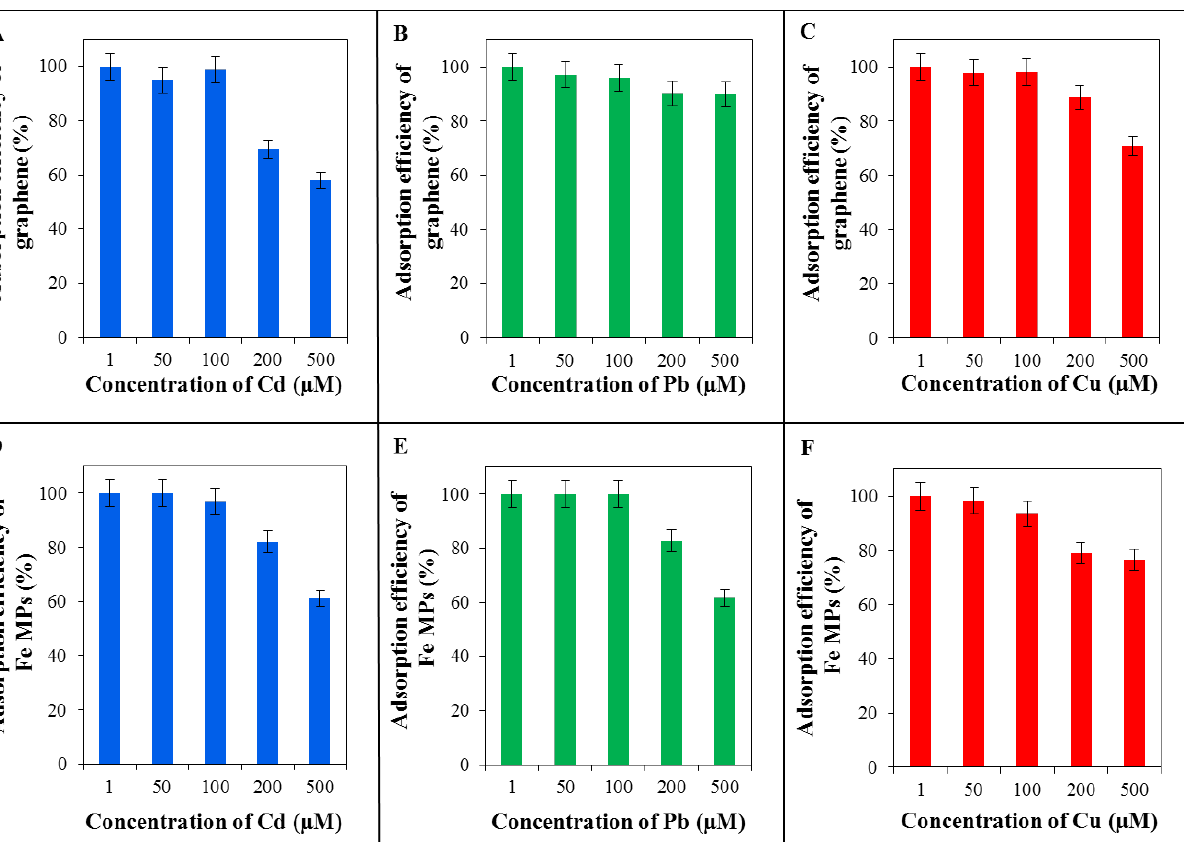
Figure 5. Determination of the concentration of adsorbent capacity of graphene (reduced graphene oxide): concentration capacity ( A ) for cadmium; ( B ) for lead and ( C ) for copper and of Fe O MPs: concentration capacity ( D ) for cadmium; ( E ) for lead and ( F ) for 2 3 copper. Efficiency of adsorption for each metal is plotted on the y-axis